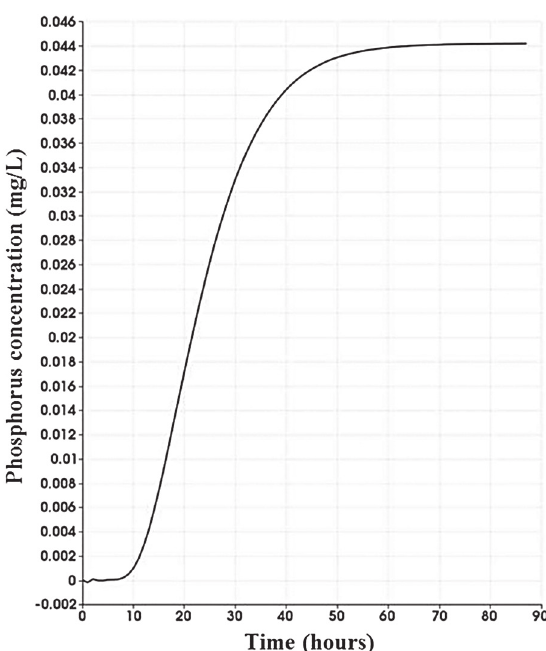
Figure 10 - Temporal evolution of the concentration in the output of the